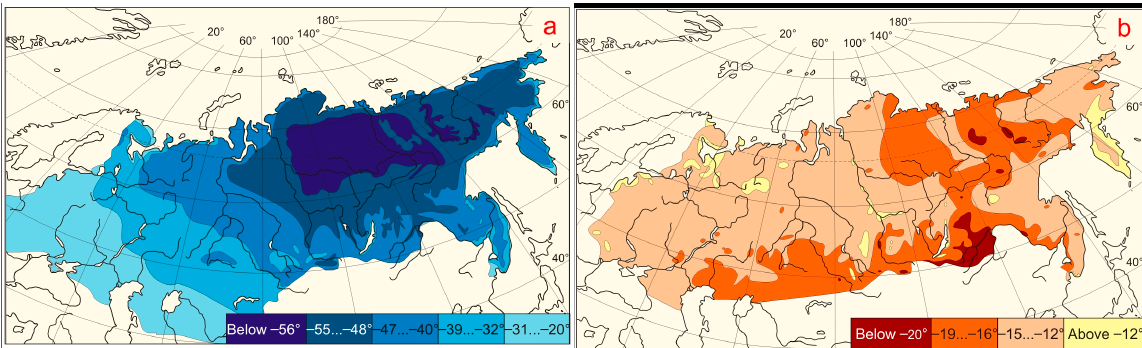
Far East (Figure 7a).